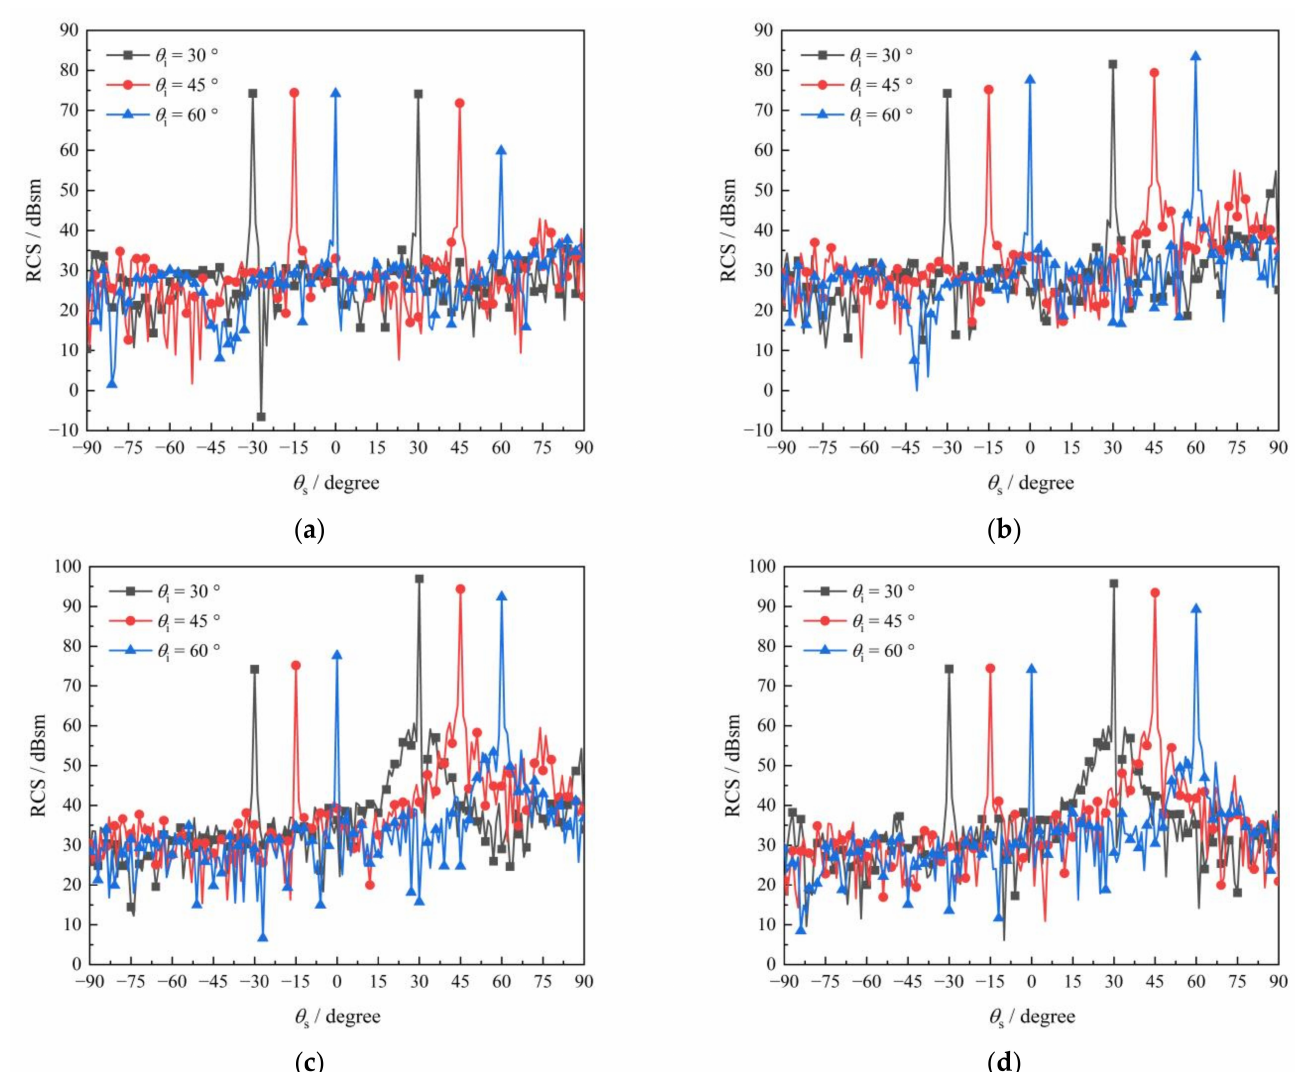
Figure 21. Bistatic RCS simulation results: ( a ) canyon, HH-polarization; ( b ) canyon, VV-polarization; ( c ) valley, HH-polarization; ( d ) valley, VV-polarization.